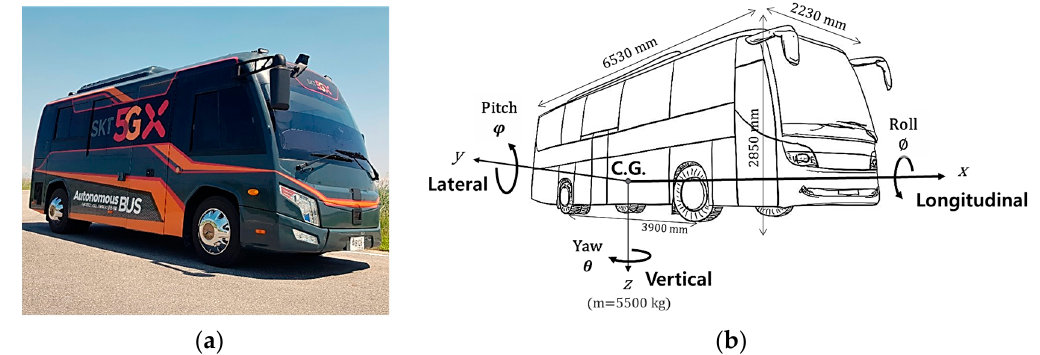
Figure 1. ( a ) Electric shuttle bus (BJ6650EVCA-2) manufactured by Foton Motor Co. used in this study, and ( b ) sketch of the vehicle with notation of movements, forces, and dimensional specifications.